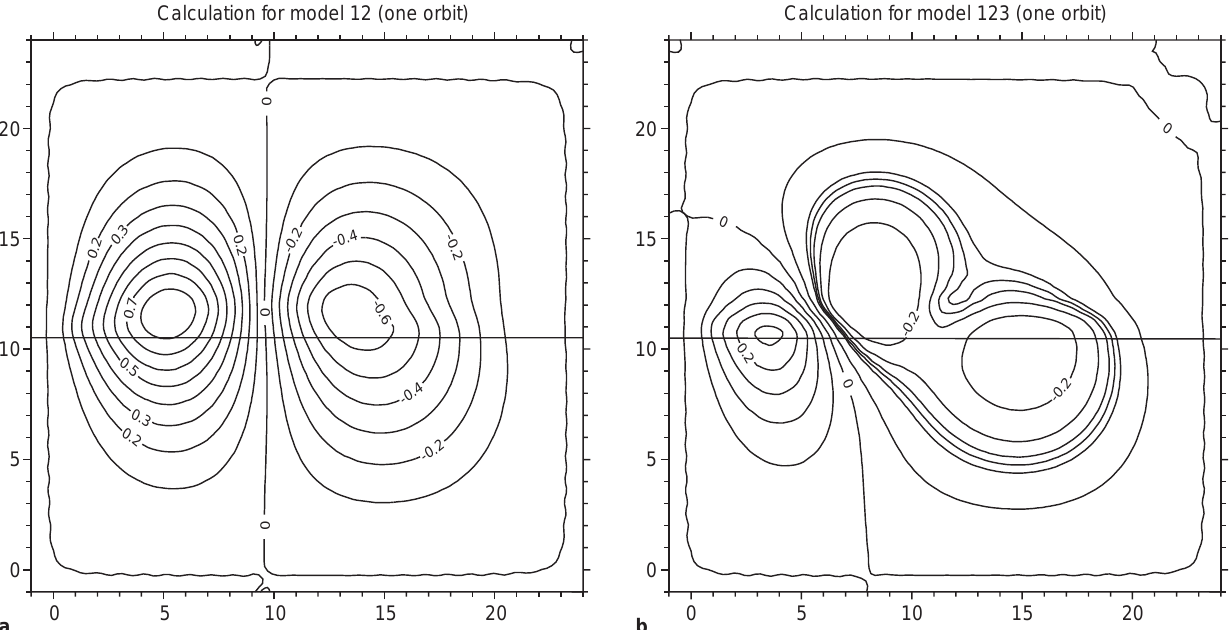
Fig. 3a, b. Convection patterns reconstructed by using the data along a single line (one orbit case). a 2-cell convection; b